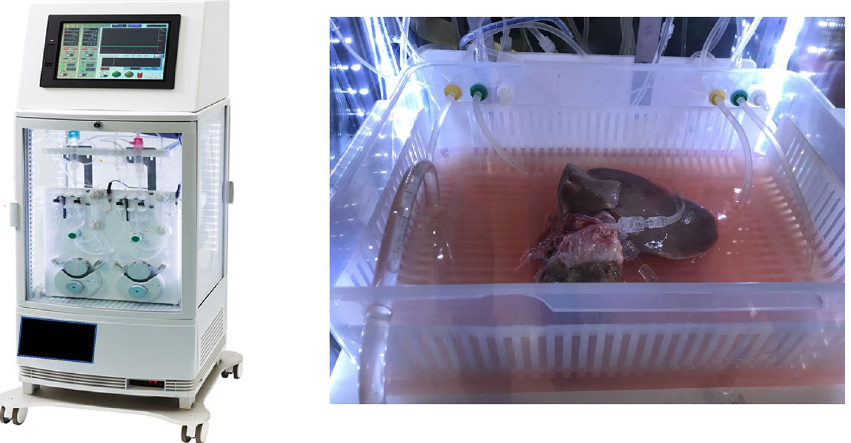
Figure 1. Perfusion preservation machine. The grafts were perfused using an originally developed MP system (CMP-X04W; Chuo Seiko Co., Ltd., Asahikawa, Japan).